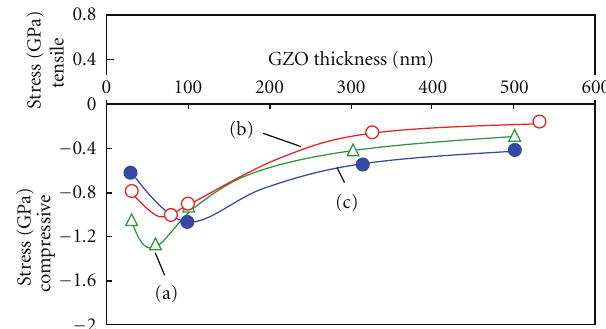
Figure 3: Comparison of the dependence of residual stress on film thickness in as-deposited GZO films prepared at 180 ◦ C by (a) RPD, (b) dc MS, and (c) rf + dc